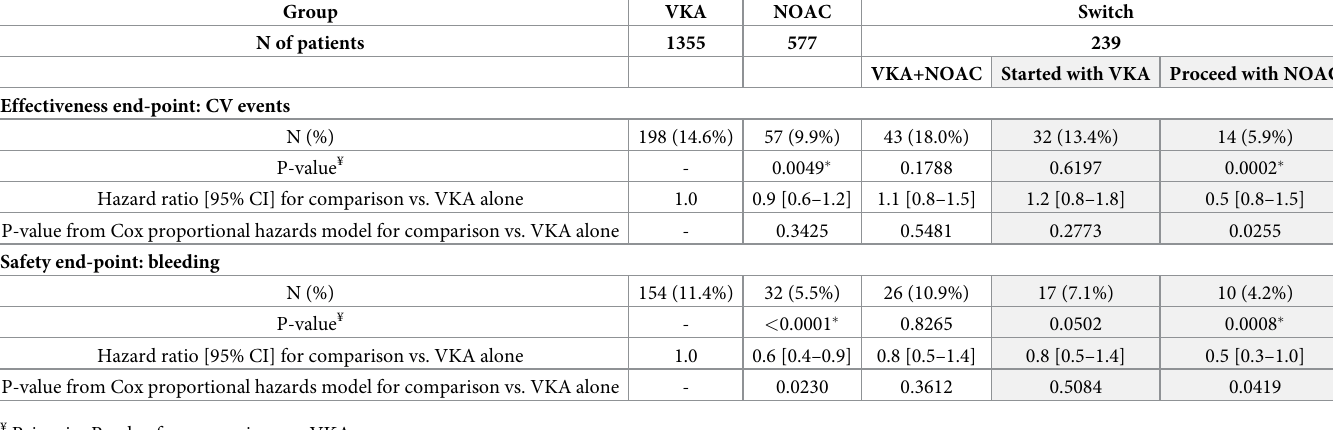
Table 2. Patients with at least one CV or bleeding event, by treatment group (VKA: VKA Group—NOAC: NOAC Group).